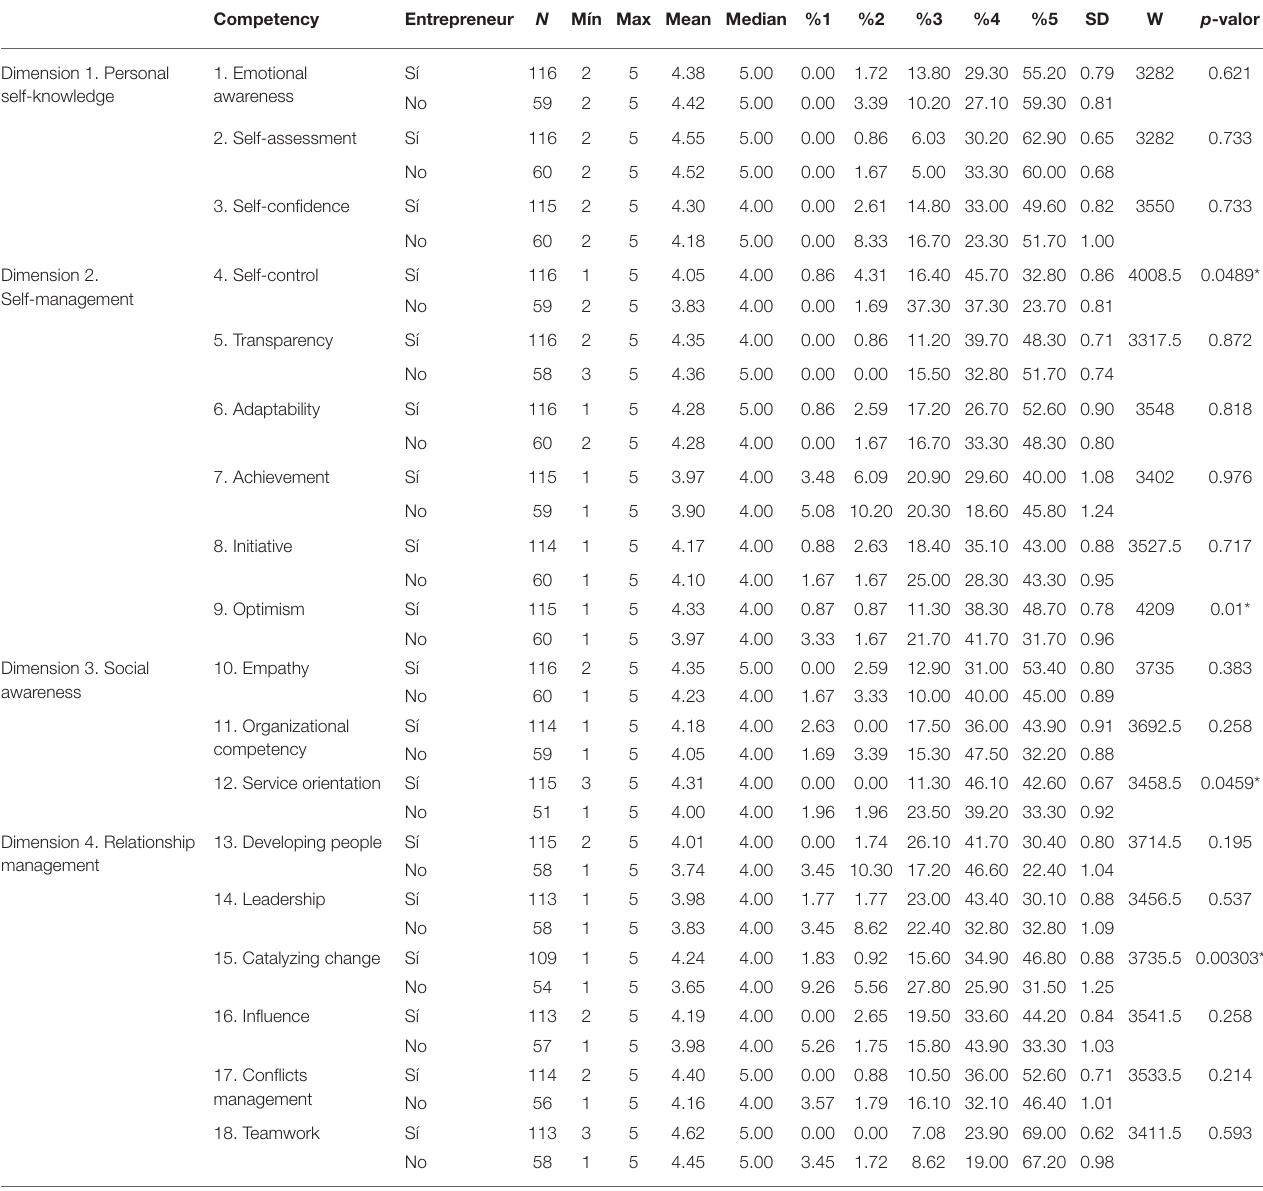
TABLE 1 | Descriptive data according to entrepreneurship and competencies of PWDs.